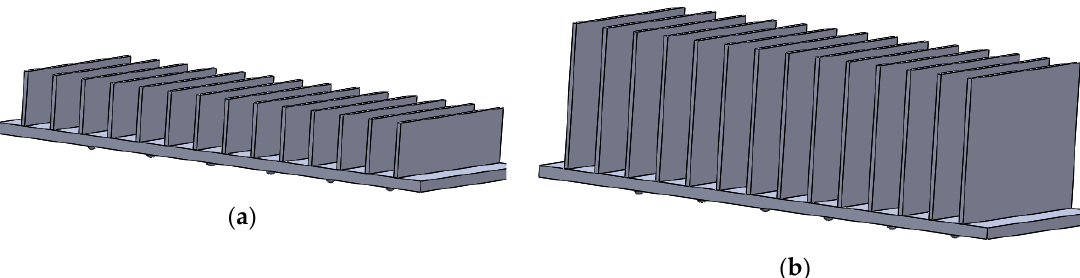
Figure 12. LED panel radiator model with 14 fins and fin heights of: ( a ) h f = 20 mm and ( b ) h f =50 mm.